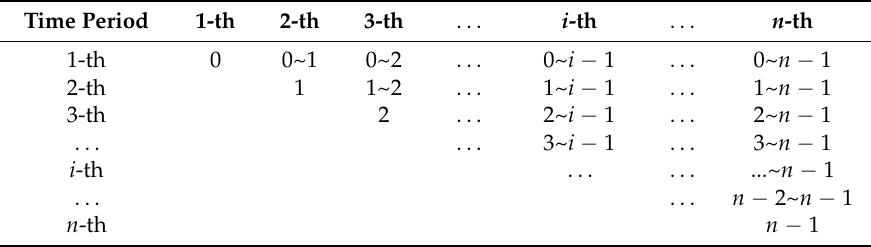
Table 1. Combination of temperature and precipitation for each time